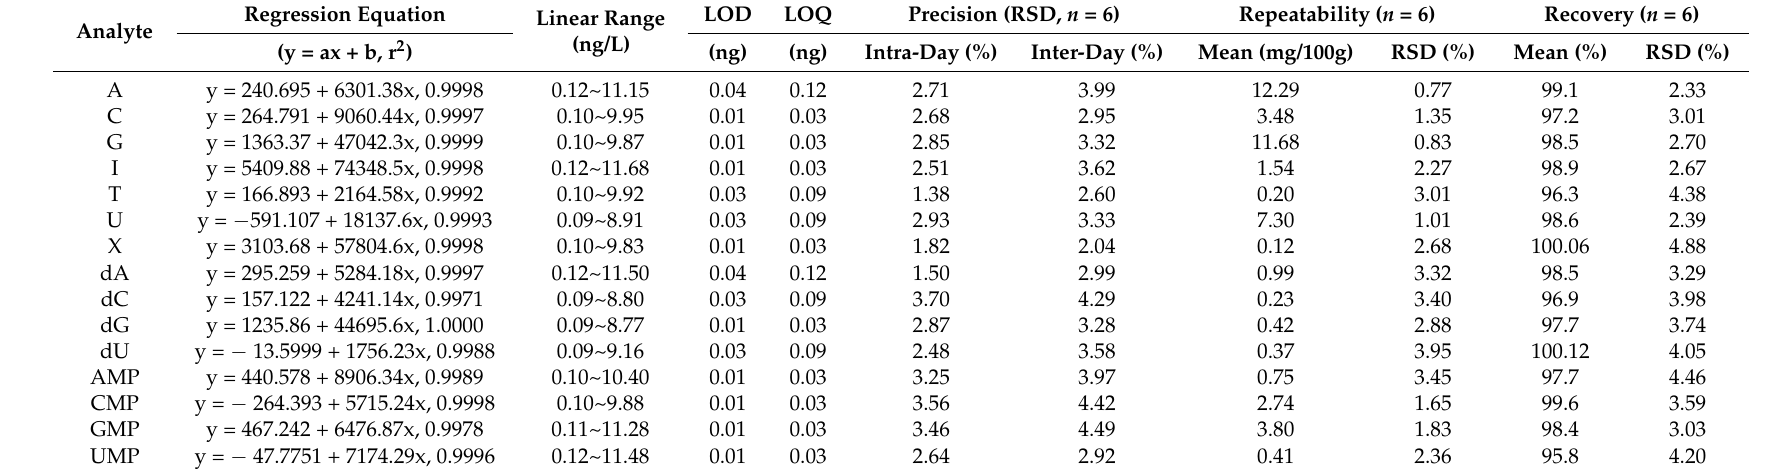
Table 2. The results of method